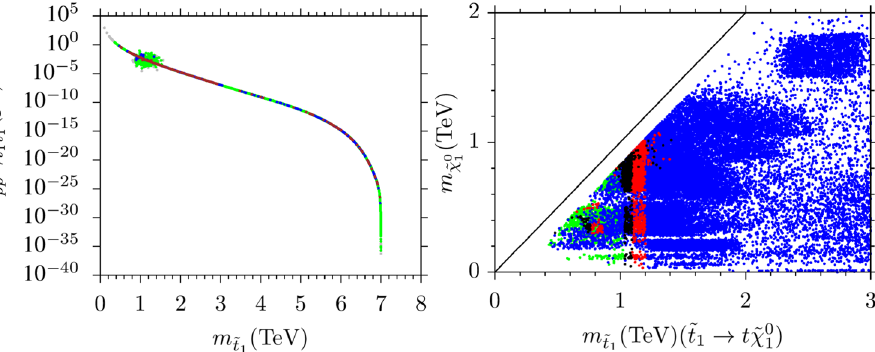
Fig. 5 Plots for the stop pair production and LSP neutralino-stop mass decays. Blue points represent the solutions with SS ( Signal 1 ) < 1, − m ˜ correlation in the σ( pp → ˜ t 1 ˜ t 1 ) − m ˜ t and m ˜ χ 0 while red, black and green correspond to 1 ≤ SS ( Signal 1 ) < 2, t 1 planes. The color 1 1 2 ≤ SS ( Signal 1 ) < 3 and SS ( Signal 1 ) ≥ 3, respectively for 14 codingintheleftpanelisthesameasinFig.2.Intherightpanel,allsolu- tions satisfy the mass bounds and the constraints from rare B − meson